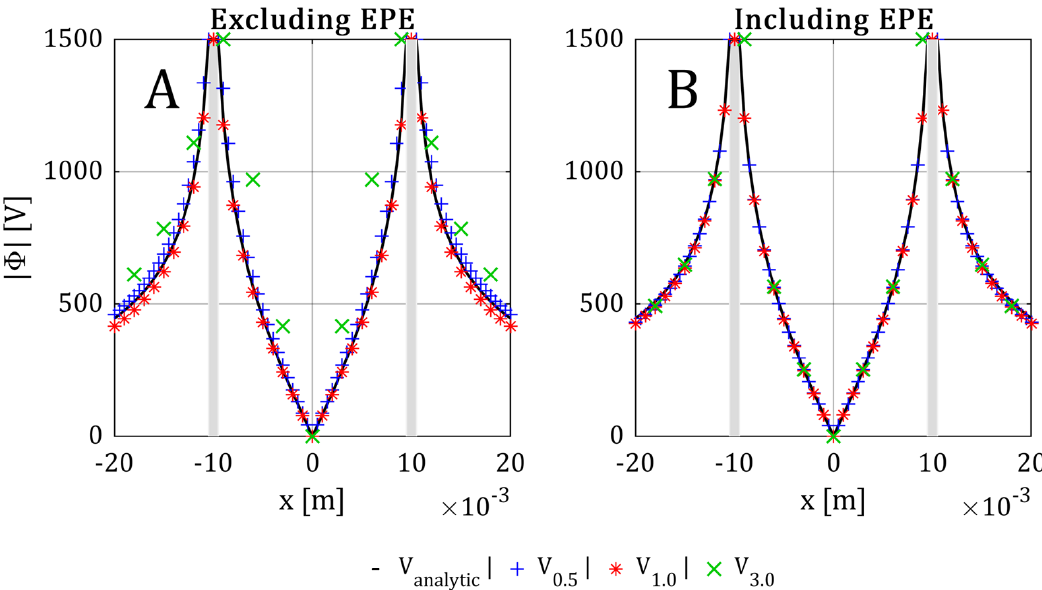
Figure 9. The absolute electric-potential distributions of a cylindrical electrode pair model (central grid) along the x-axis excluding/including the Electric-Potential Estimation (EPE). The electric-potential distributions were calculated analytically (black line), and numerically with voxel sizes 0.5 × 10 − 3 m, 1.0 × 10 − 3 m, and 3.0 × 10 − 3 m (colored symbols). In ( A ) EPE was excluded, while in ( B ) EPE was included. The grey bars illustrate the electrodes of cylindrical electrode pair.